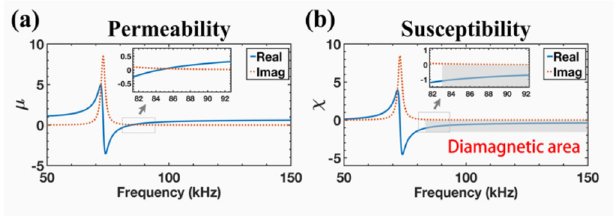
Fig. 2. (a) Permeability of the MNZ media. At 86.23kHz, m 0 0.1, m 00 0.02 (zoomed view box). (b) Susceptibility of the MNZ media. At 86.23 kHz, x 0 = (cid:3) 0.9, x 00 =0.02 (zoomed view box). The gray area indicates that the diamagnetic properties start from 83